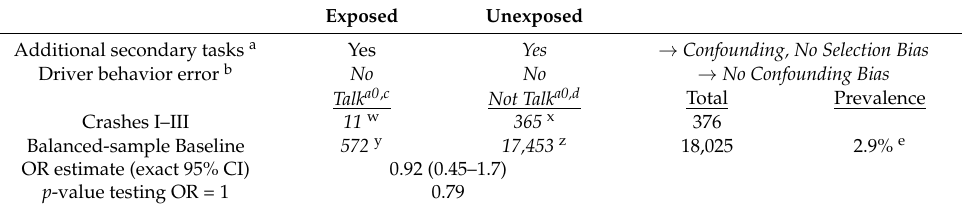
Table 6. Remove “driver behavior error” confounding bias from Table 4. Exposed